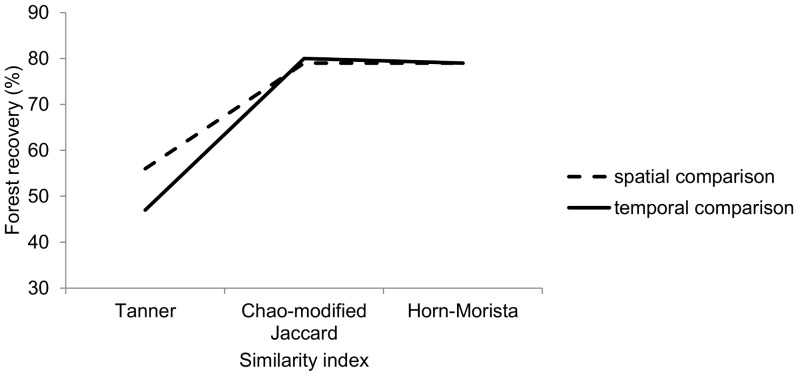
Forest recovery determined by spatial and temporal comparisons measured by the Chao-modified Jaccard index, the Horn-Morista index and the Tanner index.